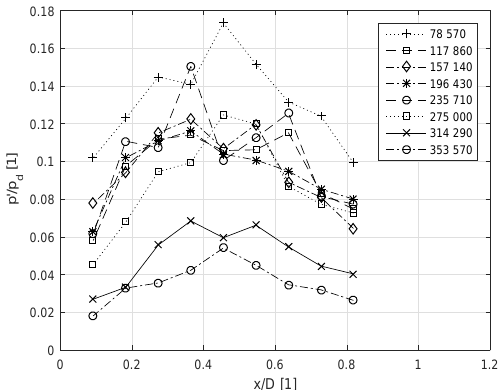
Fig. 9. The amplitude of the vortex shedding frequency in posi-tions x / D for 8 Reynolds numbers .